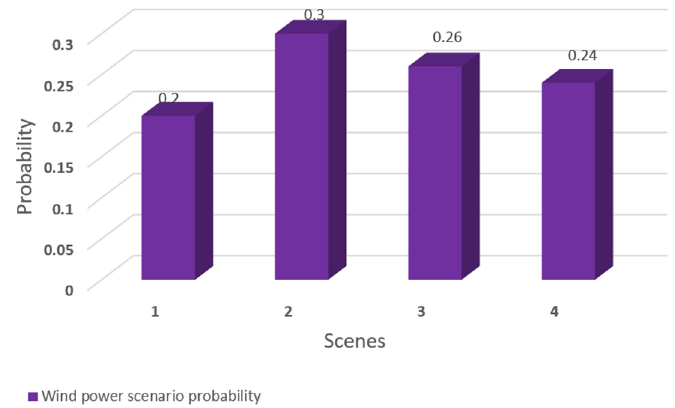
Figure 9. Wind power scenario probability.